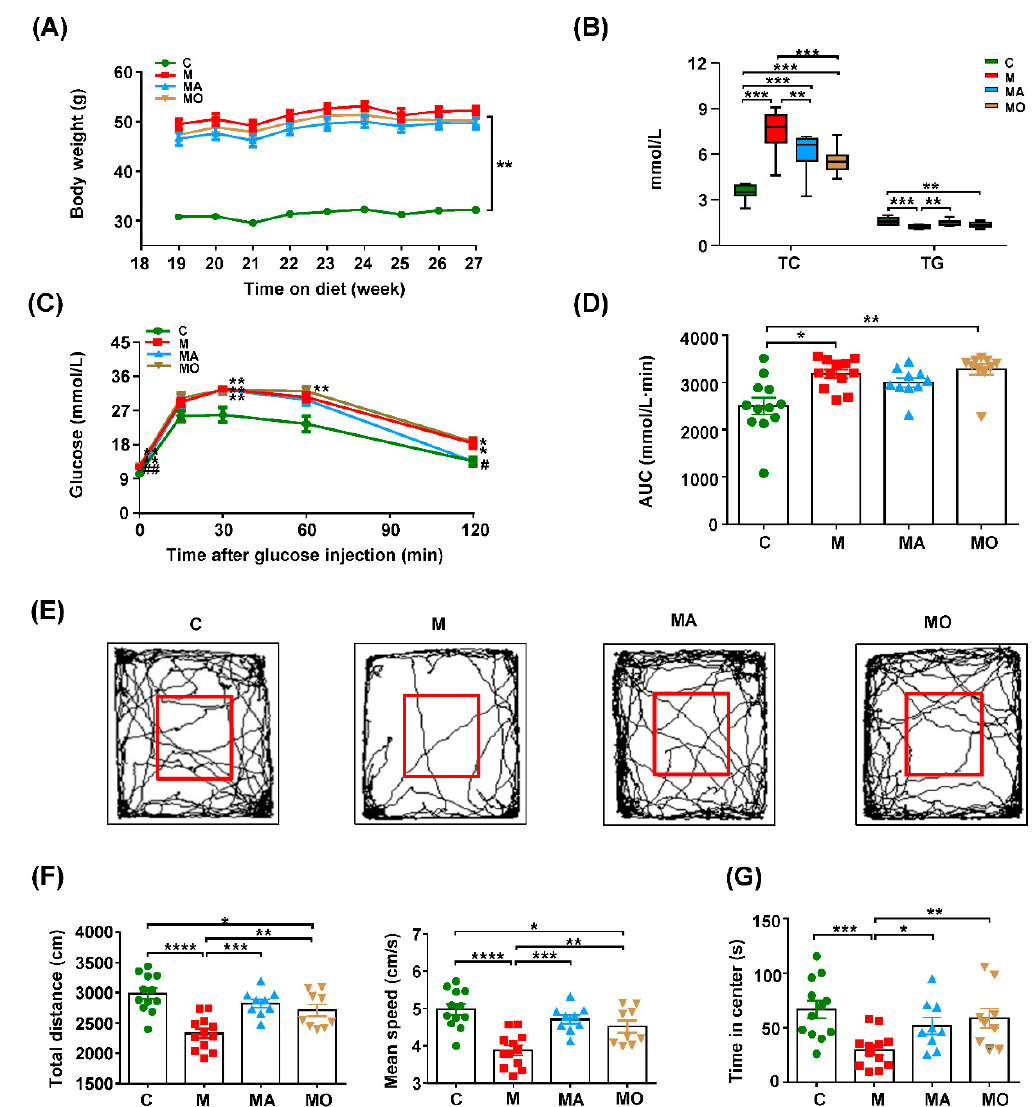
Figure 2. OCA supplementation inhibited the progression of gut microbiota-mediated anxiety in HFHS diet mice. The anxiety levels were increased with the severity of MDs in HFHS diet mice, which were inhibited by OCA or ABX treatment. ( A – D ) The body weight, serum TC and TG, GTT and the corresponding AUC were evaluated at the 27th week. ( E ) The representative trace graphs of the OF test at the 27th week. The parameters of the OF test reflecting ( F ) locomotor activity and ( G ) anxiety-like behavior are depicted. Note: data are given as mean ± SEM or medians with range. n : ( A – G ) 8–12 per group. ( A , C ) * p < 0.05; ** p < 0.01 compared with normal chow mice, # p < 0.05; ## p < 0.01 compared with HFHS diet mice with vehicle. ( B , D , G ) * p < 0.05; ** p < 0.01; *** p < 0.001; **** p < 0.0001. Groups: C, mice with normal chow; M, mice with HFHS diet; MA, ABX-treated HFHS diet mice; MO, OCA-treated HFHS diet mice. Abbreviations: HFHS, high-fat, high-sugar; MDs, metabolic disorders; ABX, antibiotics; OCA, obeticholic acid; TC, total cholesterol; TG, triglyceride; GTT, glucose tolerance test; AUC, area under the curve; SEM, standard error of mean; OF, open field.